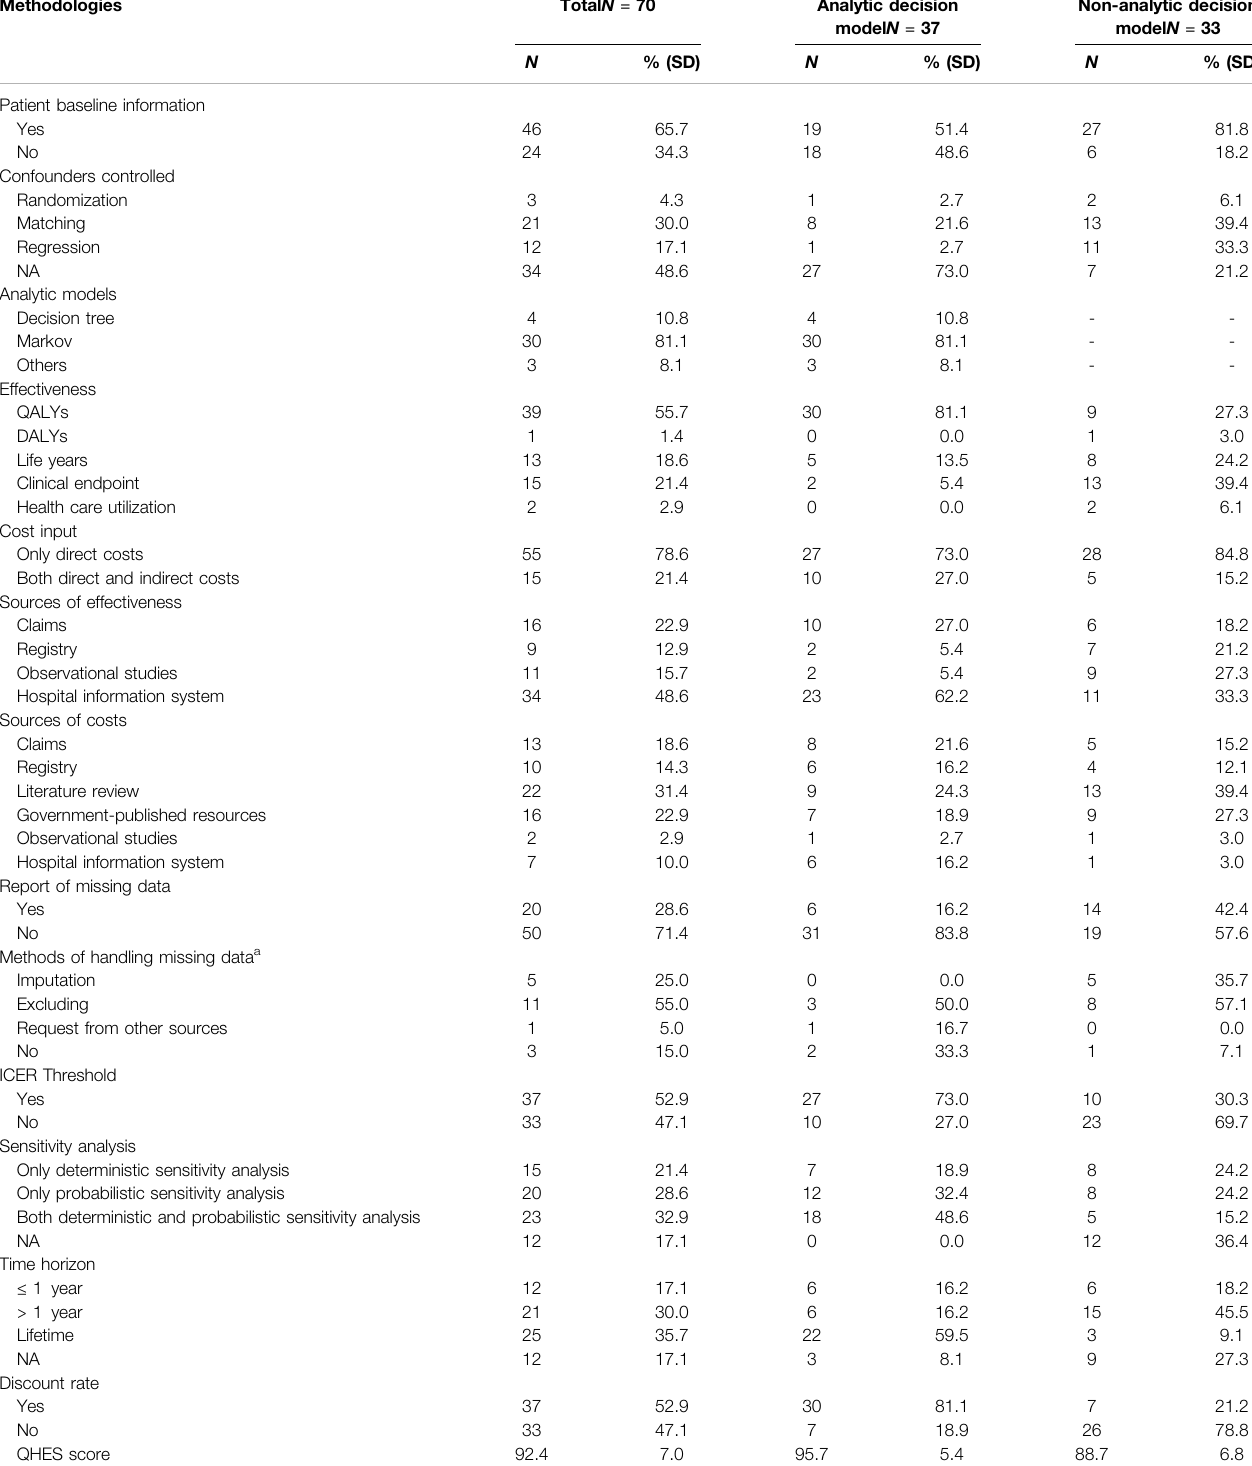
TABLE 2 | The methodologies used of included